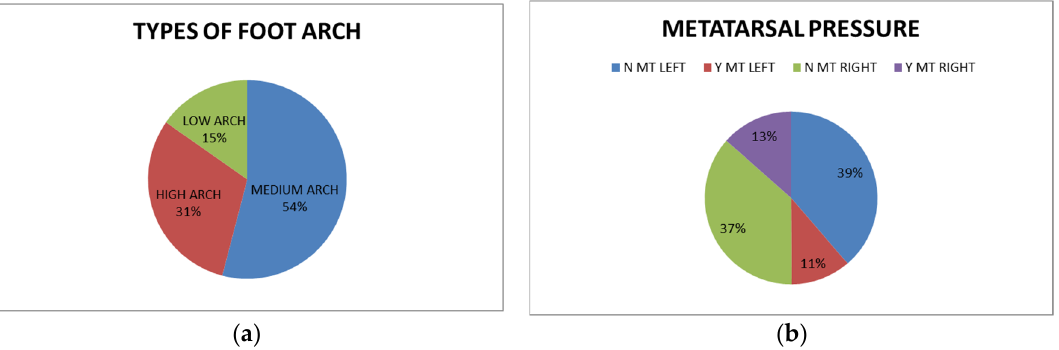
Figure 6. ( a ) The frequency of foot arch types; ( b ) The presence of metatarsal (MT) pressure in subjects in a young population.